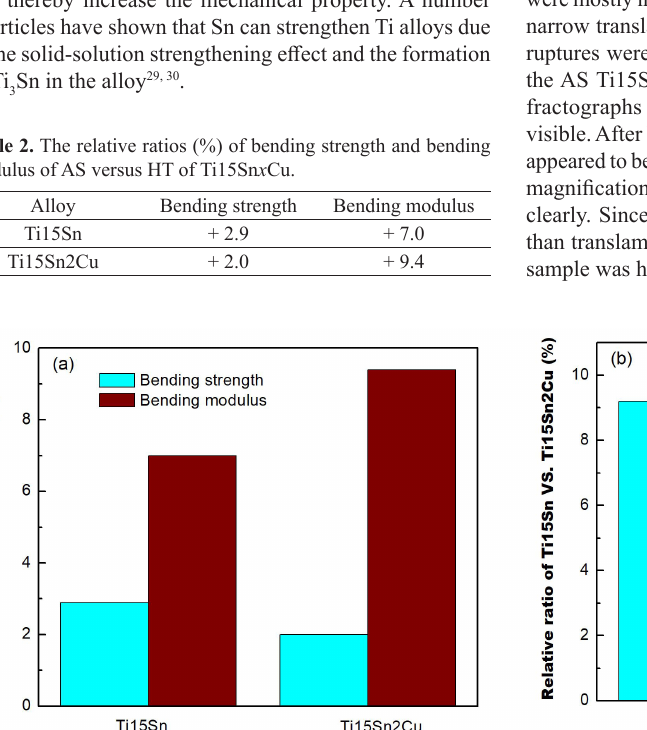
Figure 5. The relative ratios (%) of both bending strength and bending modulus: (a) AS versus HT and (b) Ti15Sn versus